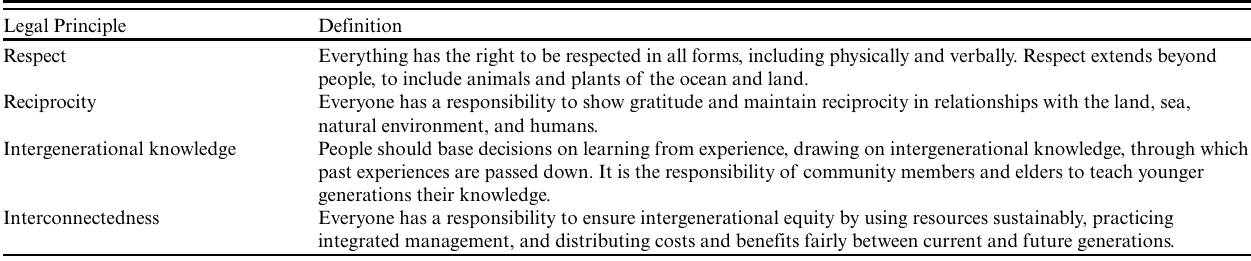
Table 1 . General Kitasoo/Xai’xais legal